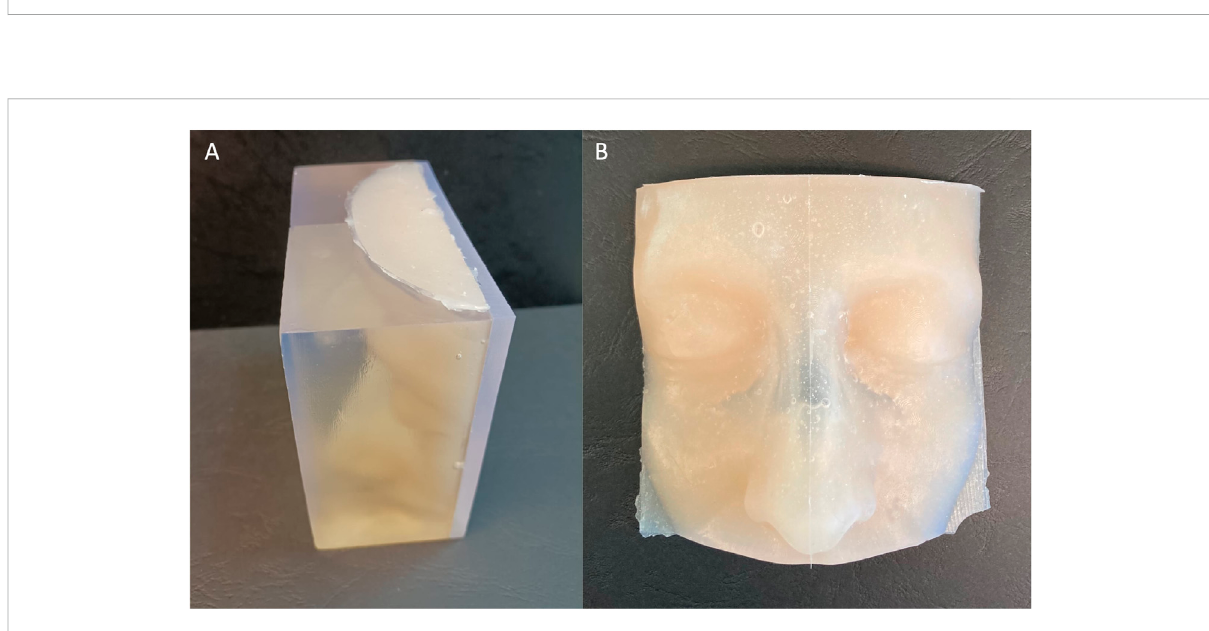
FIGURE 5 External view of the facial skin mold fi lled with silicone (A) and the obtained physical model after silicon casting (B) .